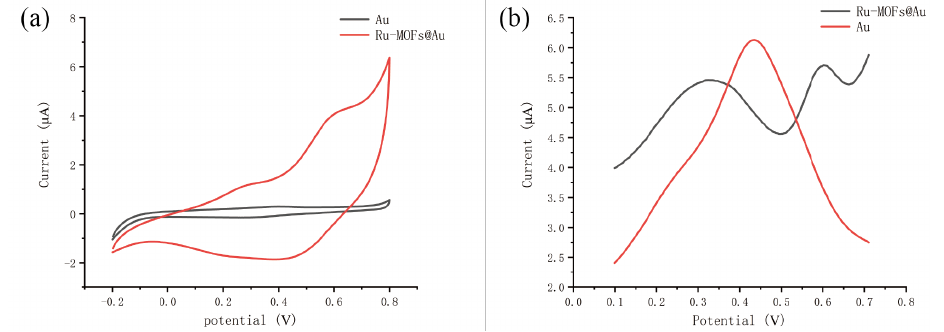
Figure 4. ( a ) CV scan from − 0.2 V–0.8 V in 0.1 M KCl. ( b ) DPSV in 5 ppb Hg 2 + solution, the deposition condition was 120 s at − 0.8